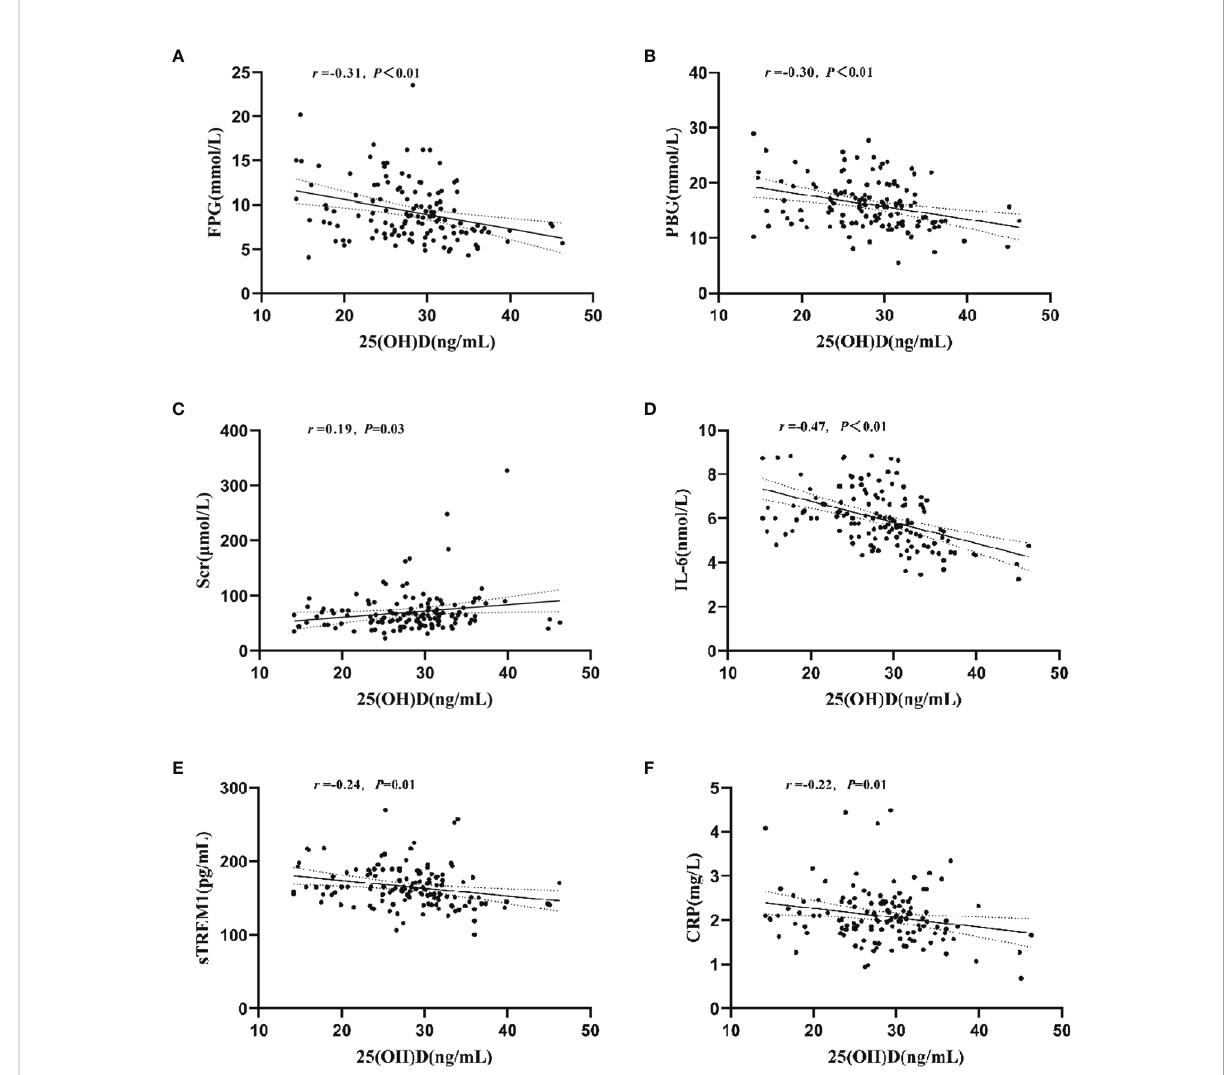
FIGURE 2 Relationship between plasma 25(OH)D level and plasma concentrations of FPG, PBG, Ser, IL-6, sTREM1, and CRP. (A) Correlation between plasma 25(OH)D and FPG levels; (B) Correlation between plasma 25(OH)D and PBG levels; (C) Correlation between plasma 25(OH)D and Scr levels; (D) Correlation between plasma 25(OH)D and IL-6 levels; (E) Correlation between plasma 25(OH)D and Strem1 levels; (F) Correlation between plasma 25(OH)D and CRP levels.